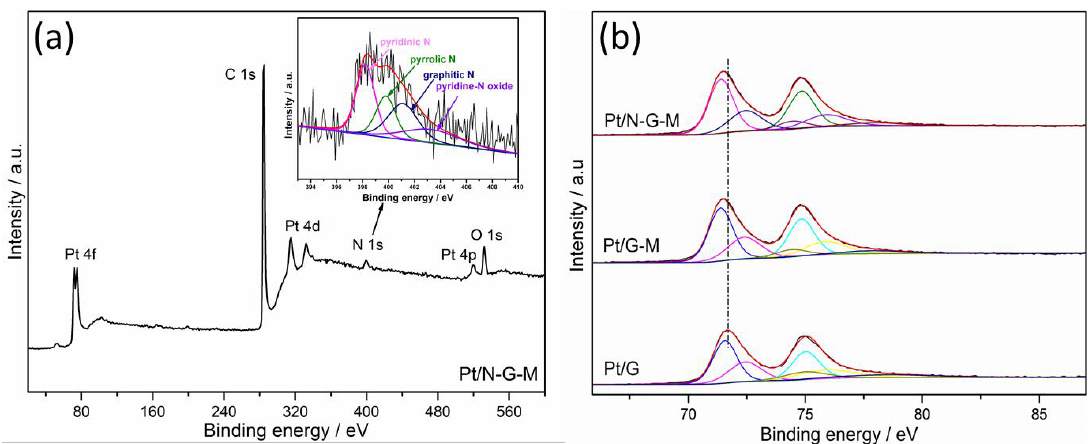
Figure 5. XPS spectra of Pt/N-G-M ( a ), the corresponding N 1s spectrum (inset); ( b ) the comparison of the Pt 4f binding energy of Pt/G, Pt/G-M, and Pt/N-G-M.